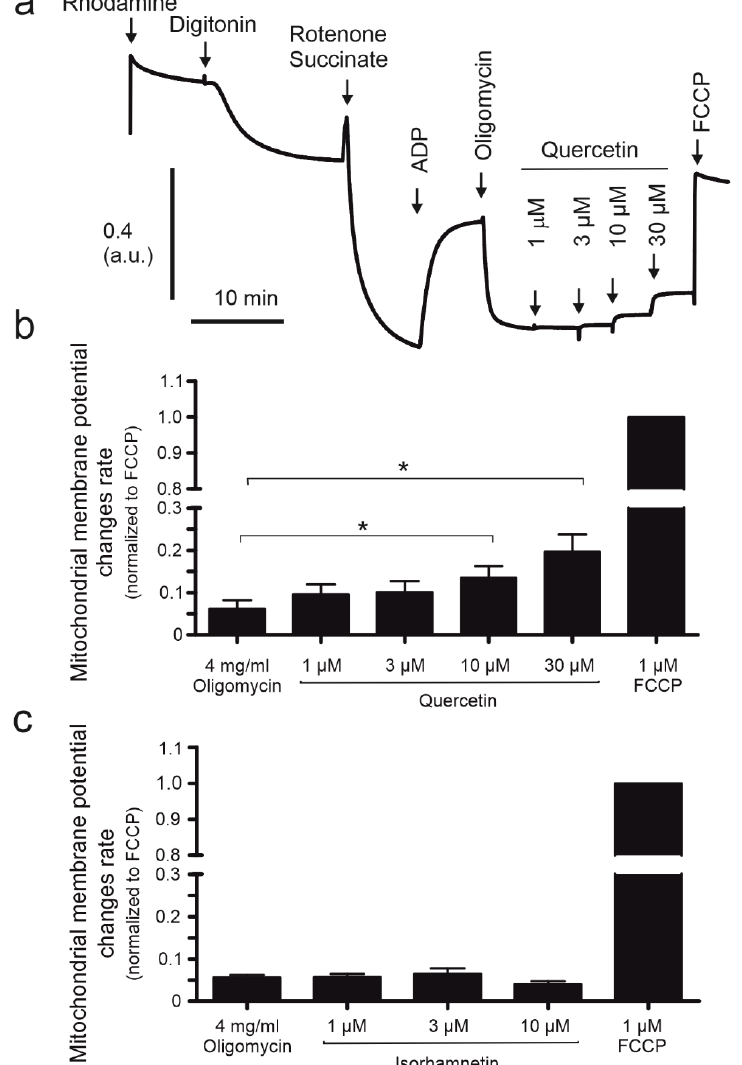
Figure 4. The effect of quercetin and isorhamnetin on mitochondrial membrane potential. ( a ) Rep- resentative recording of mitochondrial membrane potential after application of 1.3 µM rhodamine, 10 µM digitonin, 0.5 µM rotenone, 2 mM succinate, 2.5 µM ADP, 4 µg/mL oligomycin, quercetin (1, 3, 10, 30 µM), and finally, 1 µM FCCP. Below, the bars represent the effect of quercetin at different concentrations (1, 3, 10, 30 µM) ( b ) and isorhamnetin (1, 3, 10 µM) ( c ) on mitochondrial membrane potential. The results are represented by means ± SD, n = 3. Statistical significance was determined at p < 0.05 (*) by one-way ANOVA.